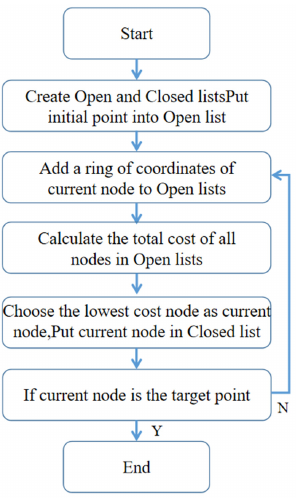
Figure 6. Flow chart of a traditional A* route planning algorithm.